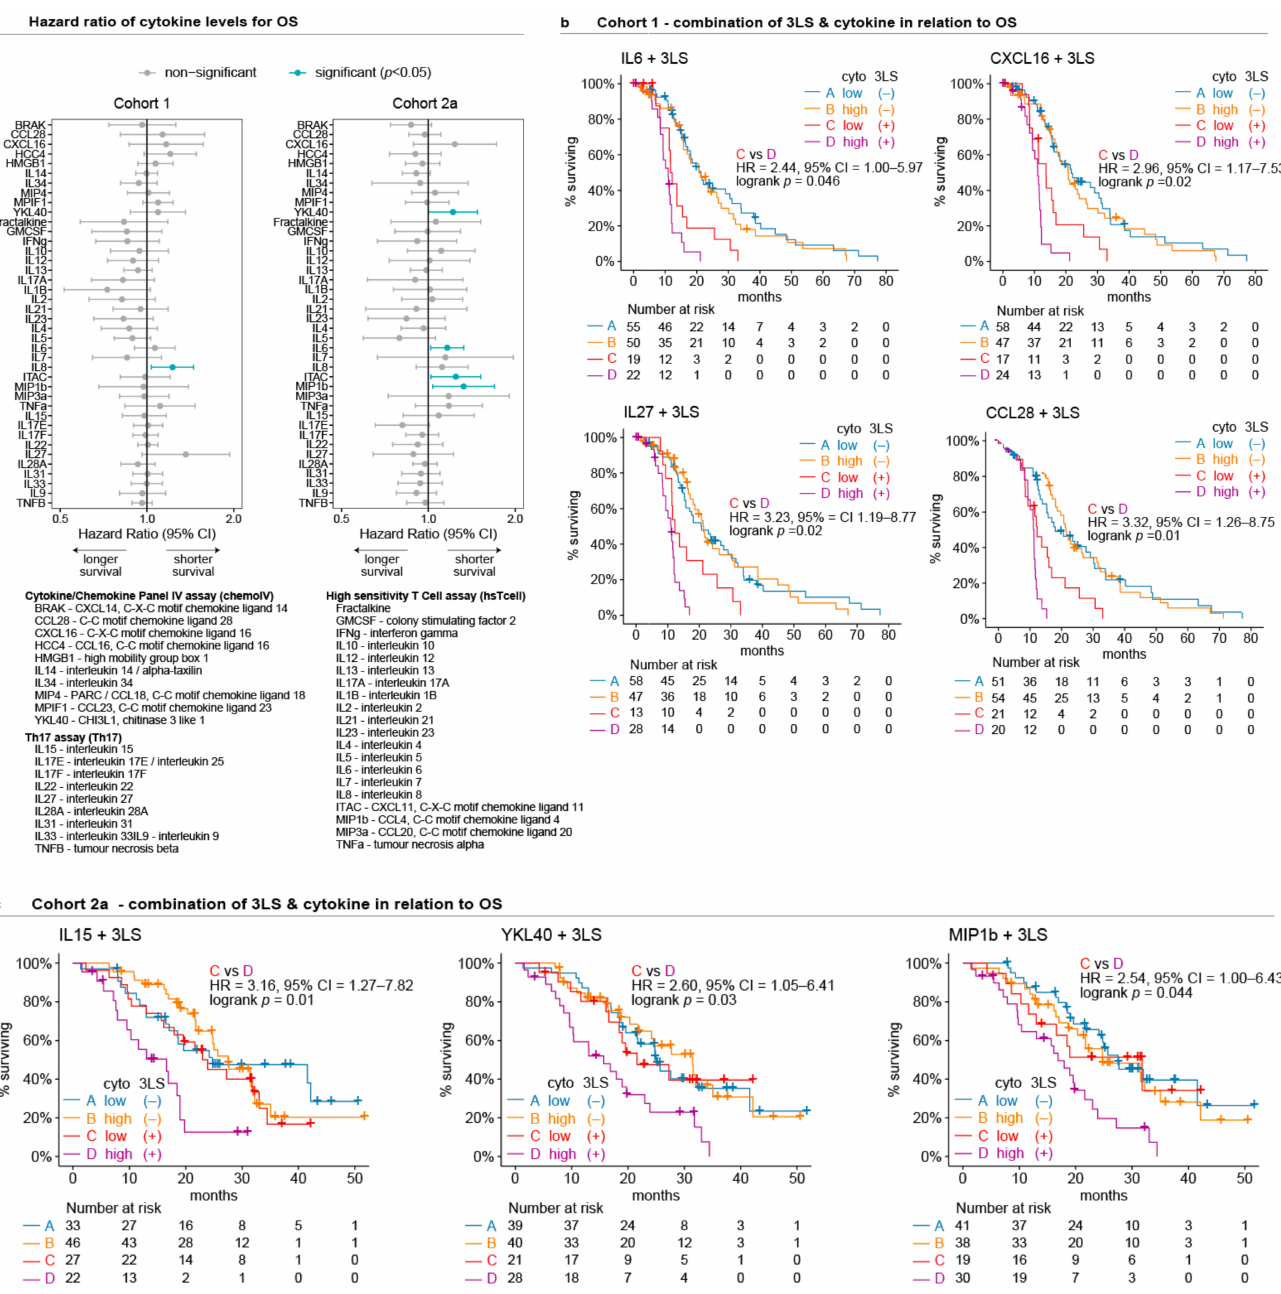
Figure 3. Prognostic baseline levels of circulating cytokines for Cohort 1 and Cohort 2a: ( a ) Forestplots of hazard ratios for baseline plasma levels of cytokines in relation to OS; ( b , c ) Kaplan–Meier curves of the combined presence of 3LS with cytokine levels in relation to OS in Cohorts 1 and 2a, respectively (high cytokine level = above median, low cytokine level = below